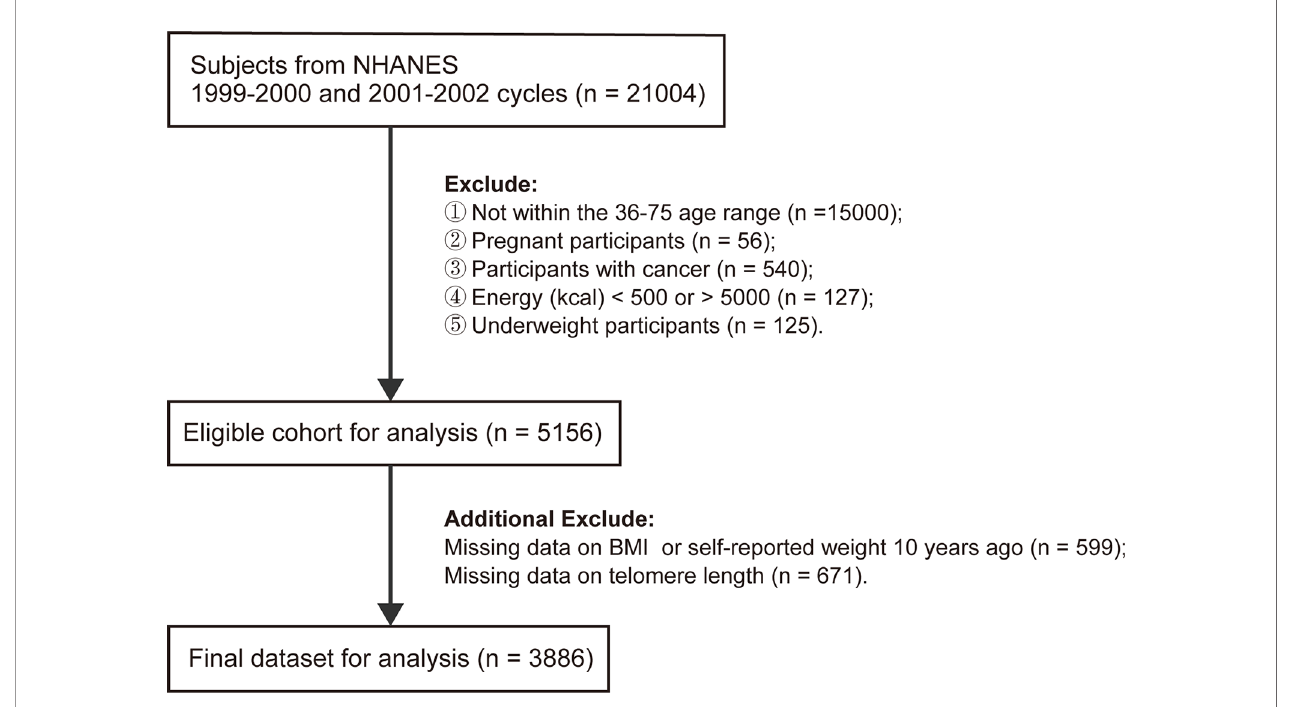
FIGURE 1 | Flowchart of eligible subjects included in this